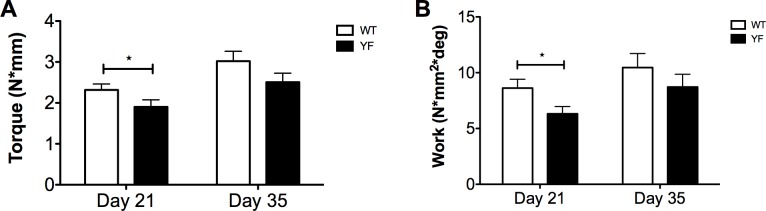
Fractured femora lacking Cbl-PI3K interaction are delayed in restoring mechanical strength.Torsion testing was performed on fractured femora during remodeling of the hard callus at 21 and 35 days post-fracture. Bar graphs show A. Peak torque and B. Work. n = 11 *p<0.05 vs. WT.